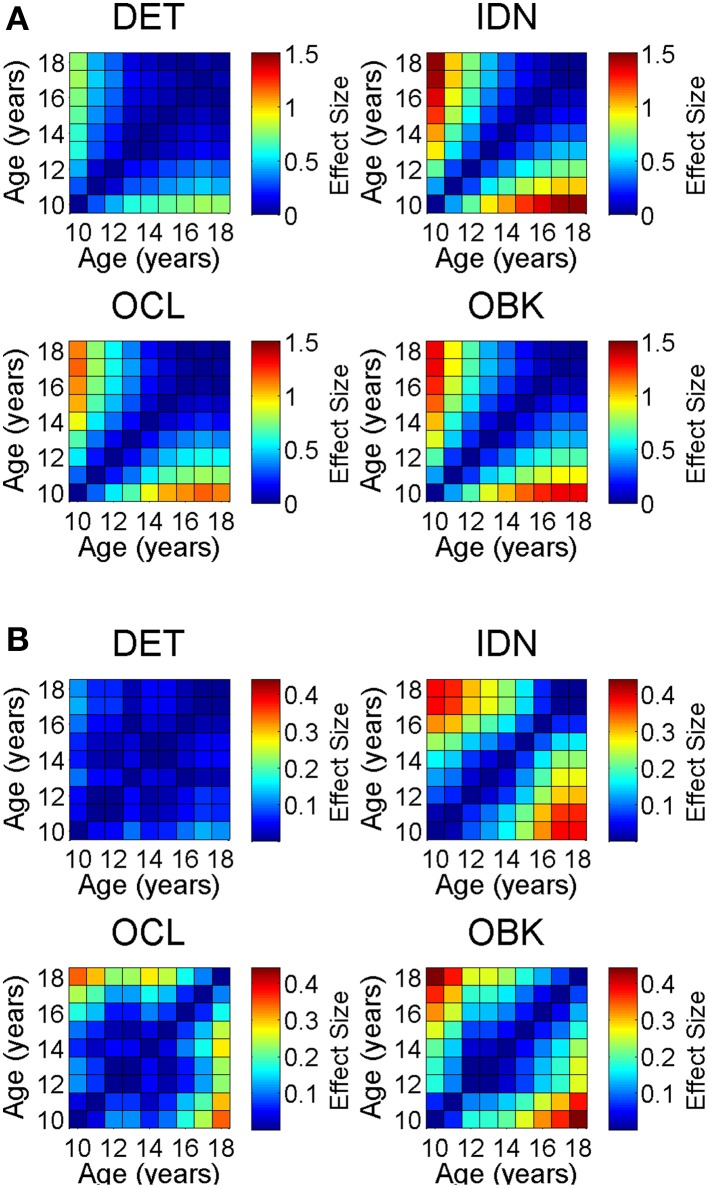
Correlation matrices showing the effect size on speed (A) and accuracy (B) of change in cognition across any combination of ages between 10 and 18 for each task in the CBB. The diagonals represent the unity line where the same age is compared with itself and therefore all effect sizes on the diagonal are zero (e.g., age 10 vs. 10). Color scales representing effect size magnitude are different on (A) vs. (B) indicating larger effect sizes for speed vs. accuracy.